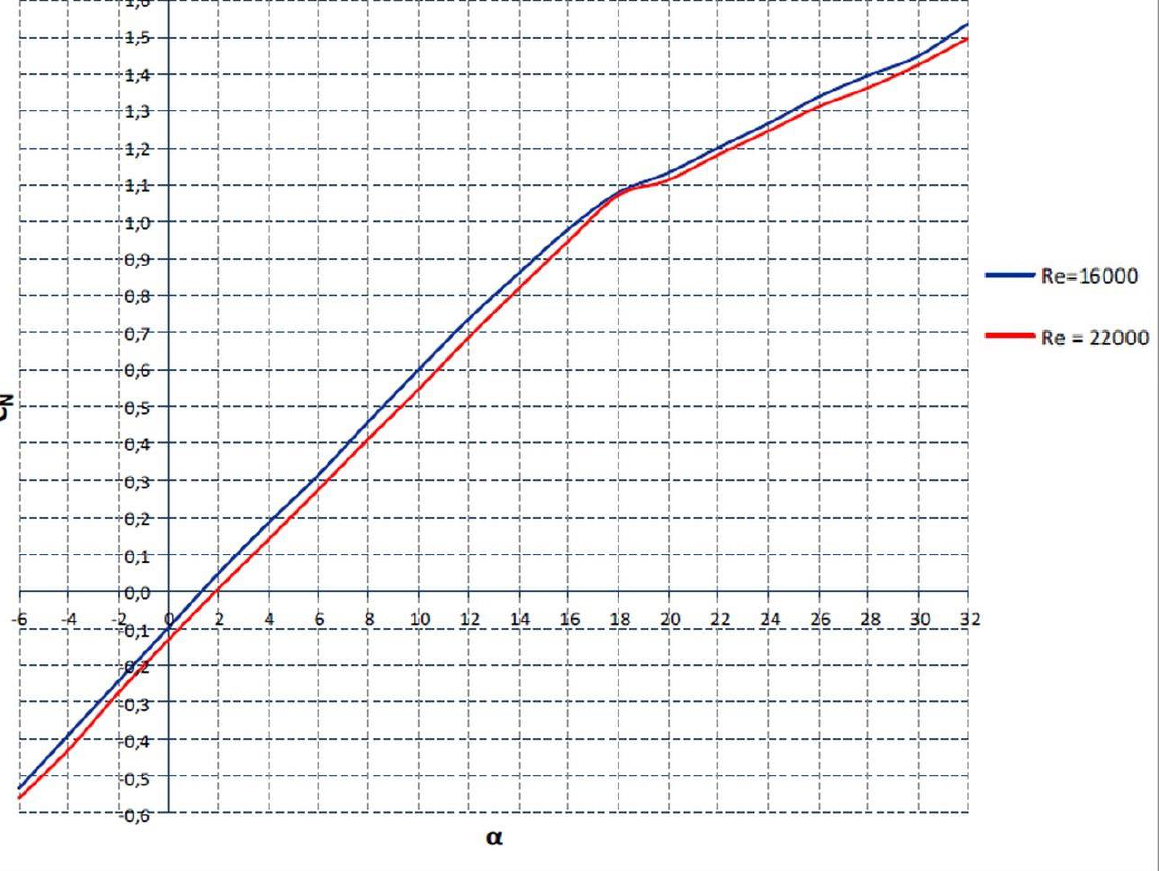
Figure 4. Dependence of normal force coefficient (C N ) = f (α) for different Reynolds numbers (Re) for the FF model. As the flow velocity (airplane flight speed) increases, the coefficients of the normal force slightly decrease (Figure 4).